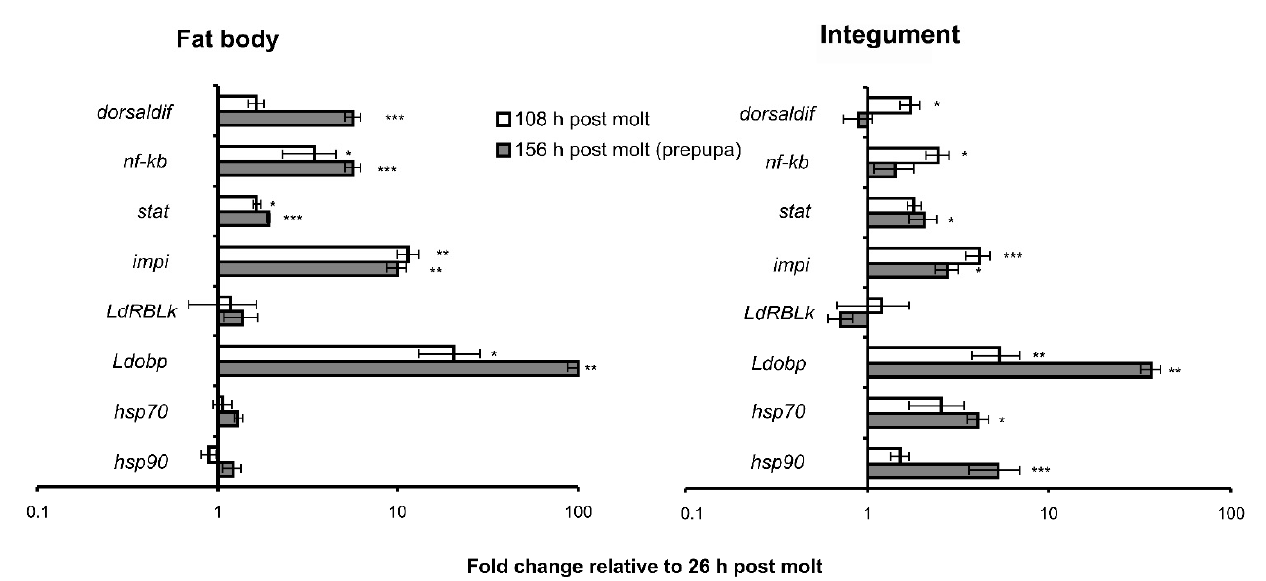
Figure 2. Changes in expression of immunity- and stress-related genes during the intermolt period in CPB larvae (instar IV, no infection). Data are presented as fold changes relative to uninfected larvae at 26 h post-molt. Genes rp18 , arf2 , and arf19 were used as references. * p < 0.05, ** p < 0.01, and *** p < 0.001 relative to larvae at 26 h post-molt (Dunn’s test).